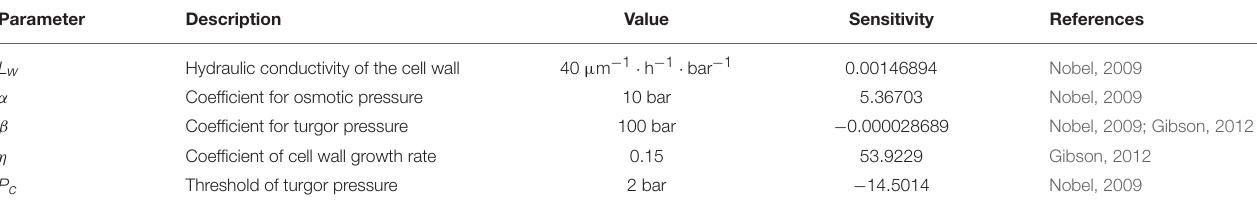
TABLE 1 | Mechanical parameters of the model.